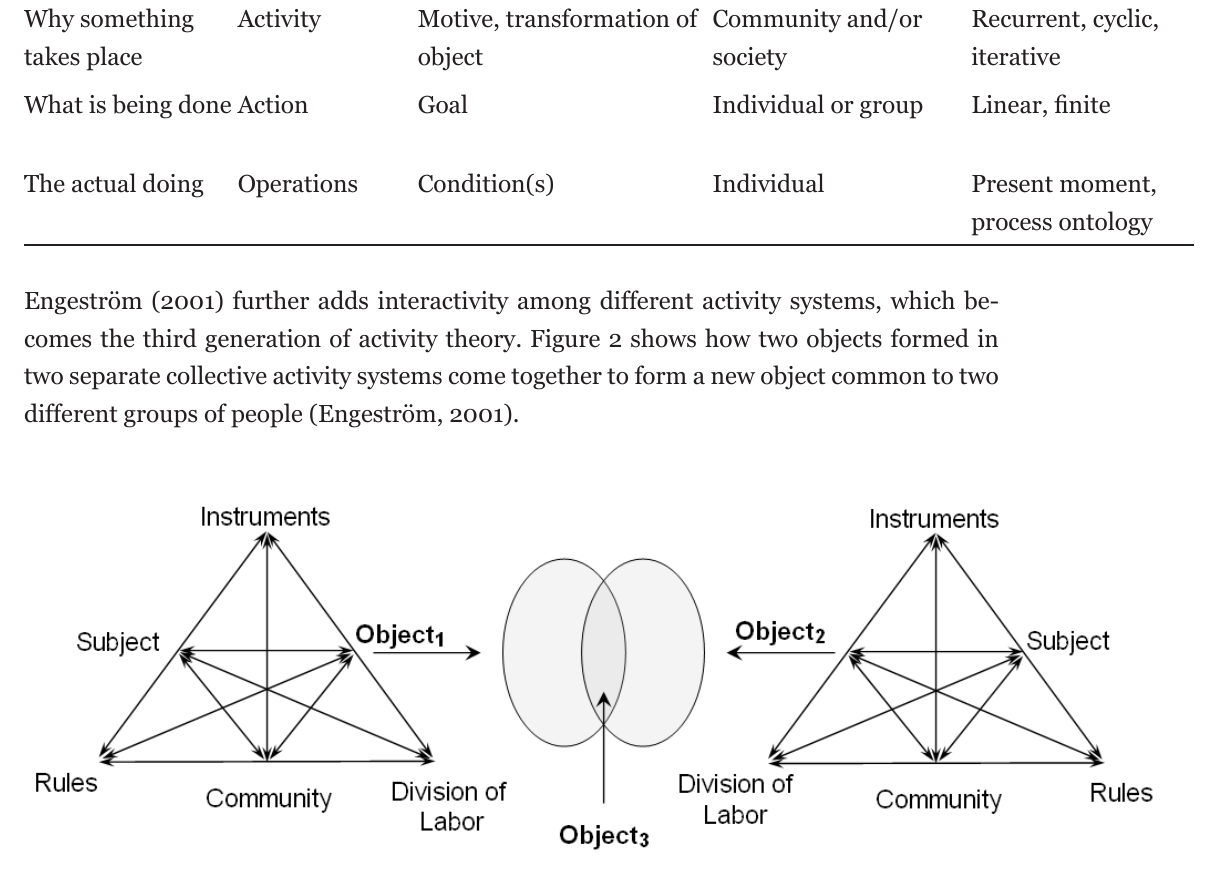
Figure 2 . A model of activity theory (Engeström, 2001, p.